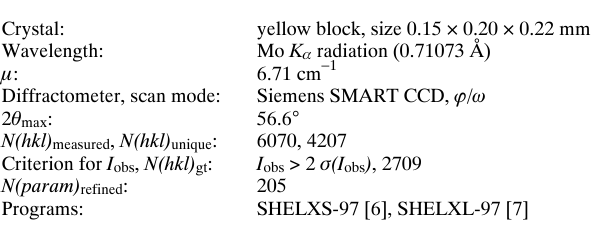
Table 1. D a t a collection a nd h a ndling.